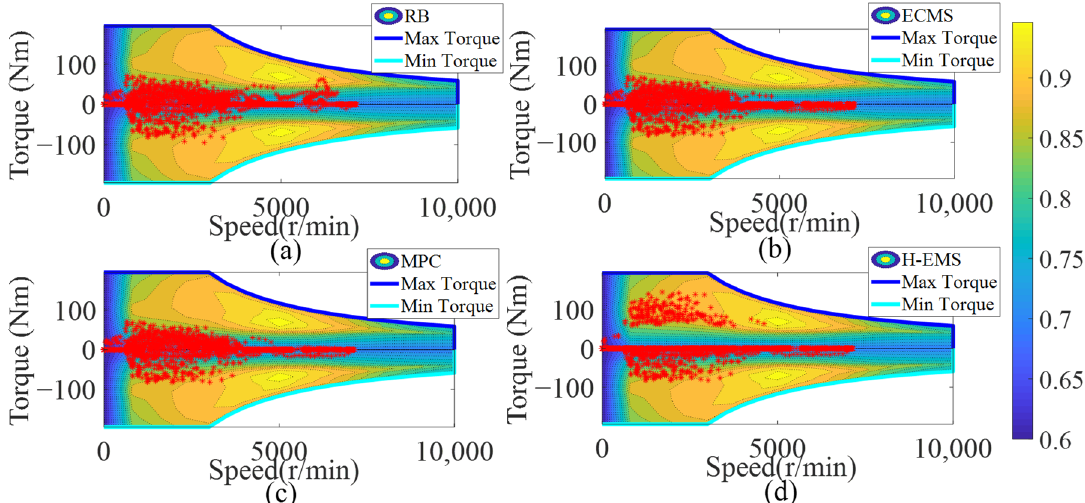
Figure 15. Rear motor operating points of energy management strategies. ( a ) RB strategy; ( b ) ECMS strategy; ( c ) MPC strategy; ( d ) H-EMS strategy.